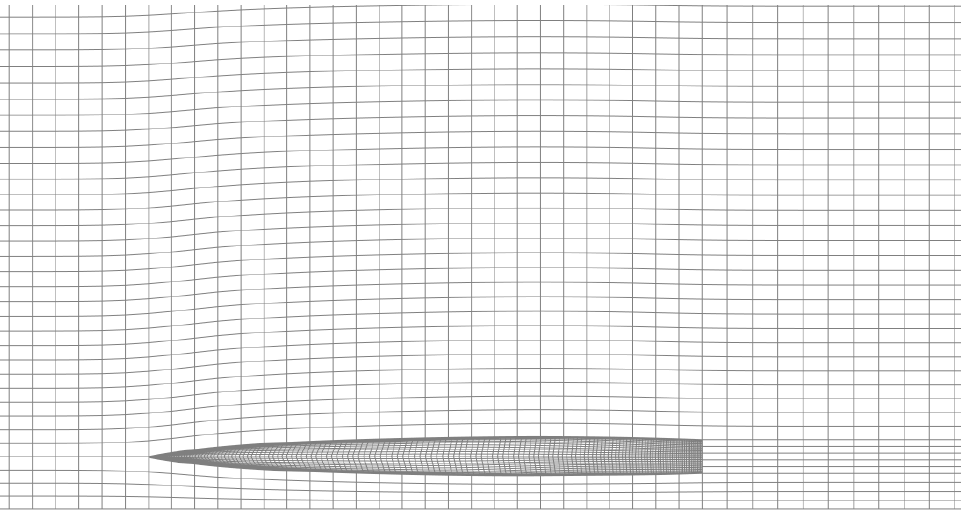
Figure 12. Close-up of the panel mesh on the hull and free surface in the vicinity of the